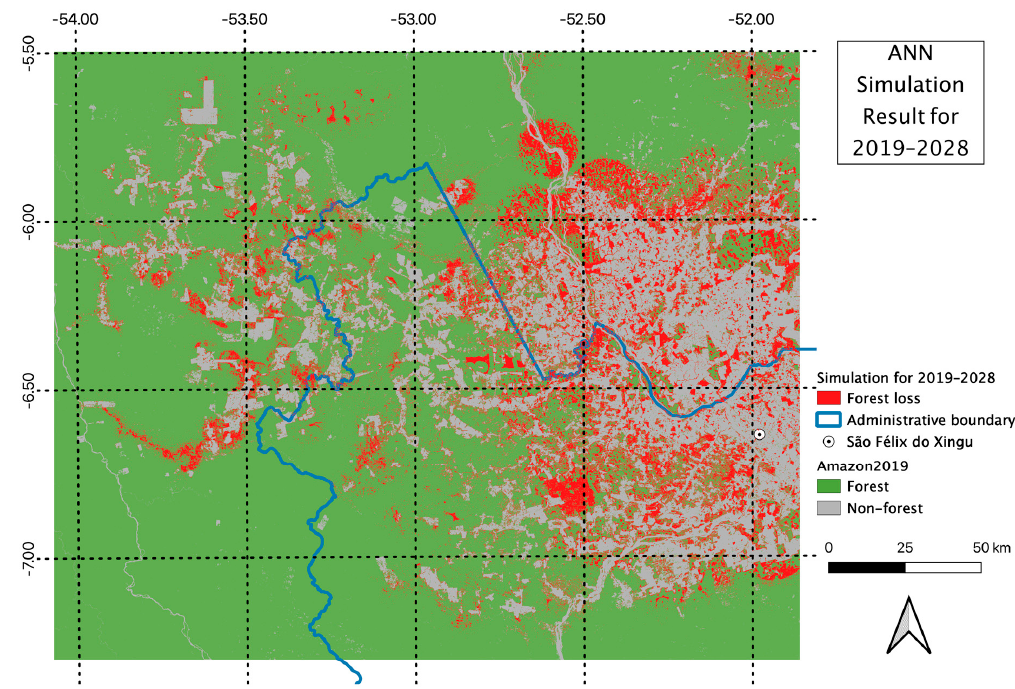
Figure 9. ANN simulation result for the year 2019 to